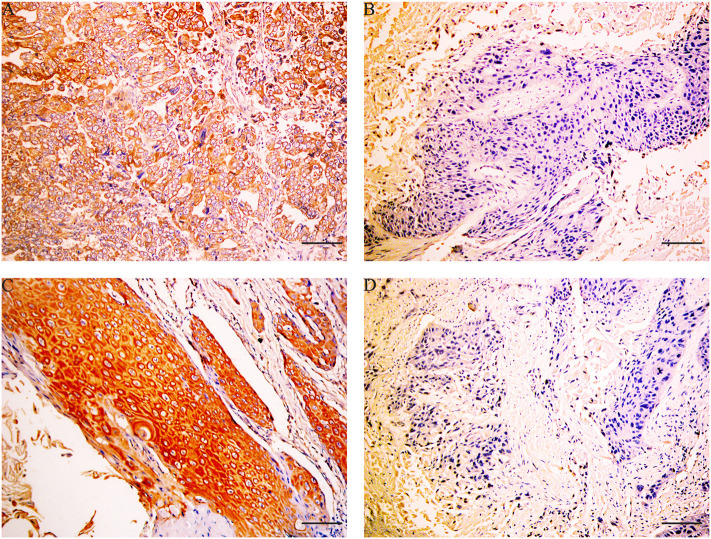
XBP1 and NAT1 expression in gallbladder ASC/SC, original magnification ×200. XBP1 expression was localized in the nuclei, and NAT1 expression was localized in the cytoplasm and/or nuclei. (A) Positive expression of XBP1 in poorly differentiated SC. (B) Negative expression of XBP1 in moderately differentiated SC. (C) Positive expression of NAT1 in well-differentiated ASC. (D) Negative expression of NAT1 in moderately differentiated ASC. Scale bars: 50 μm.